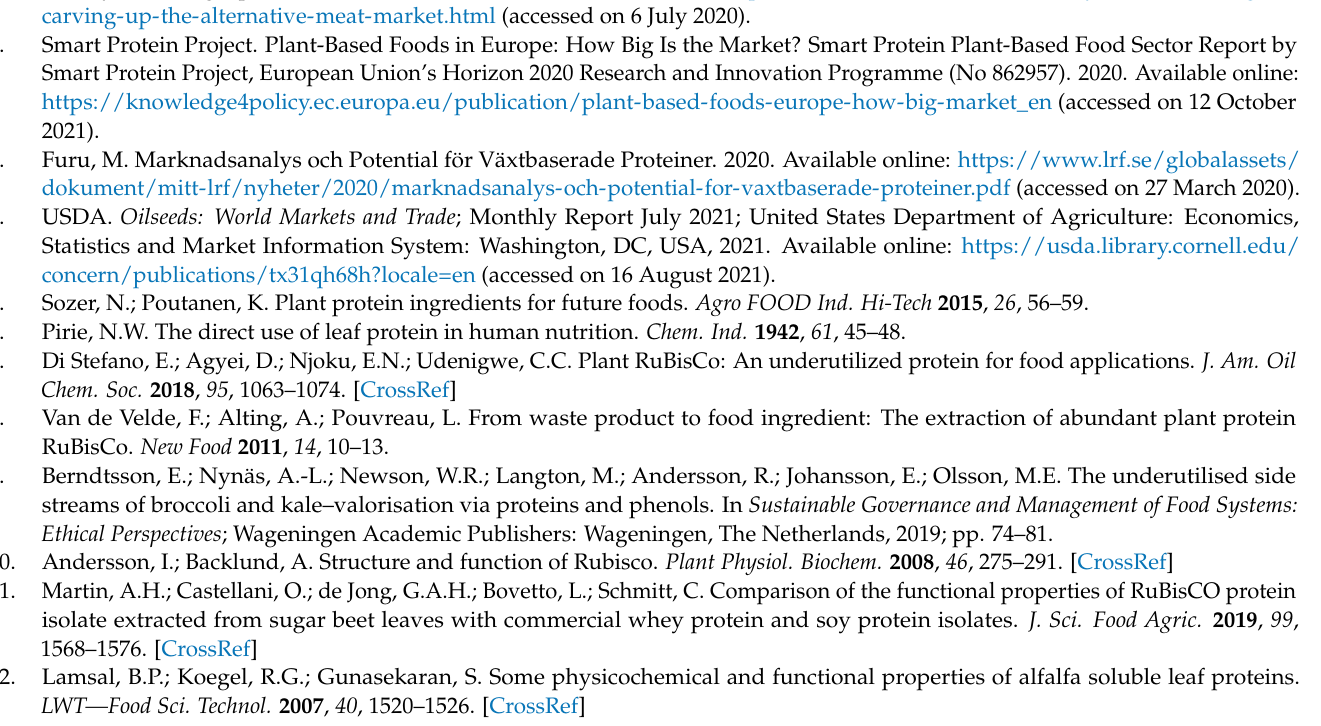
(S2), Figure S2: Visualization of N yields in some of the process steps for the different biomass types, Table S1: Yields (in %) of total mass (m), dry matter (DM), and nitrogen (N), in the white protein extraction